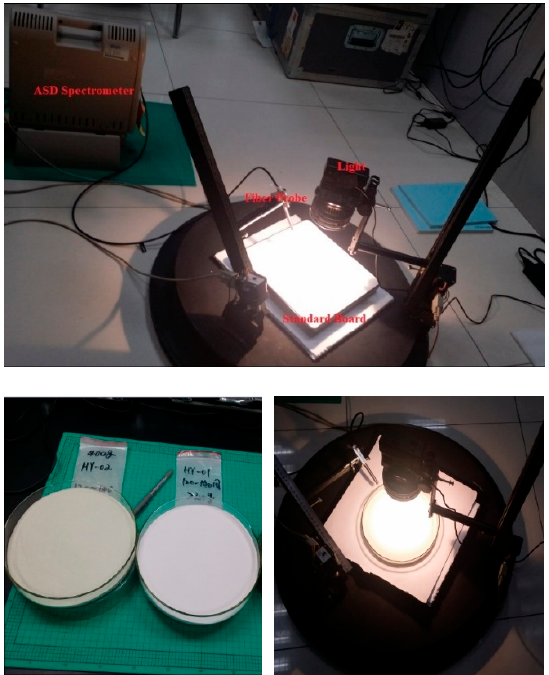
Figure 1. Measuring equipment for the multi-angle spectral data.